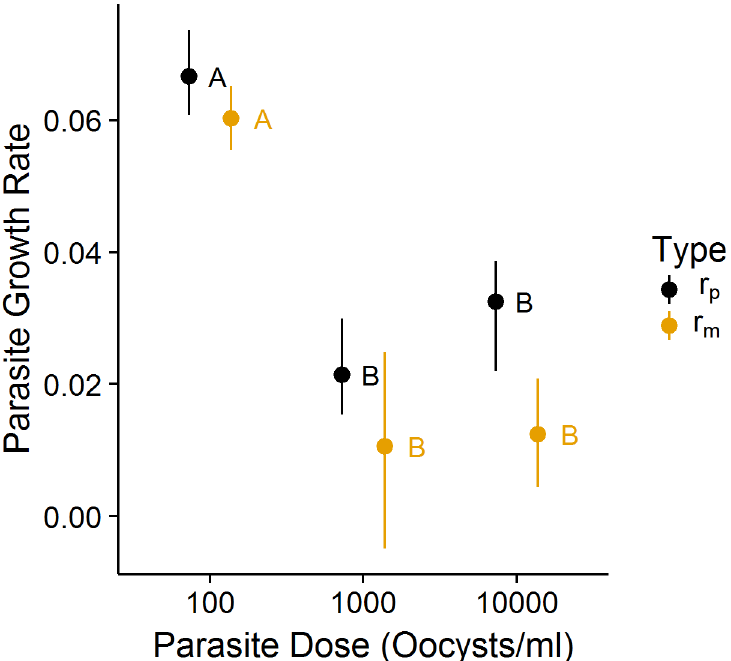
Fig 4. Two approximations of mean parasite per capita growth rate under different parasite doses to mosquito hosts. Parasite growth rate declinedsignificantly regardlessof which growth rate type, including oocysts from the male mosquito(r p ) or not includingthem (r m ) was used, suggesting an effect of density on parasitegrowth. Coloredletters correspond to separateTukey’s HSD tests on ANOVA models of each growth rate approximation. Whiskers are bootstrapped 95% confidence intervals (1000 replicates). Mean points are dodgedfor visibility.